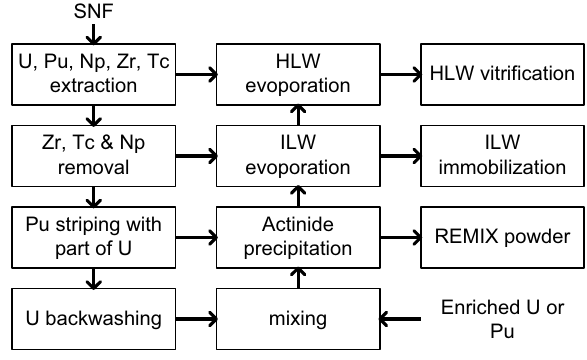
Fig. 1. The fl owchart for fabrication of REMIX fuel.